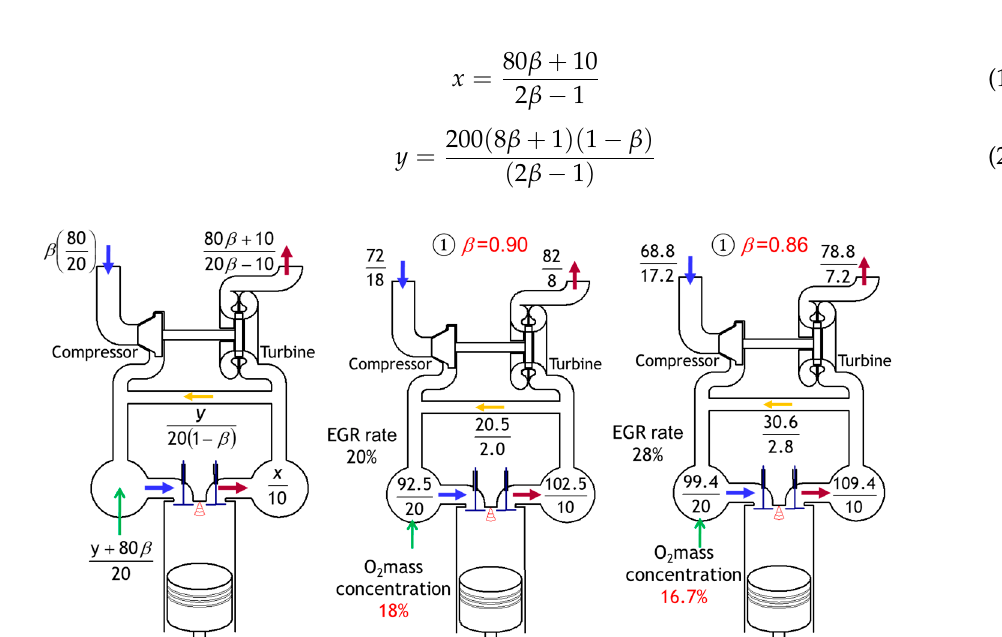
Figure 3. Mass balance of a diesel engine with EGR in the COC case.